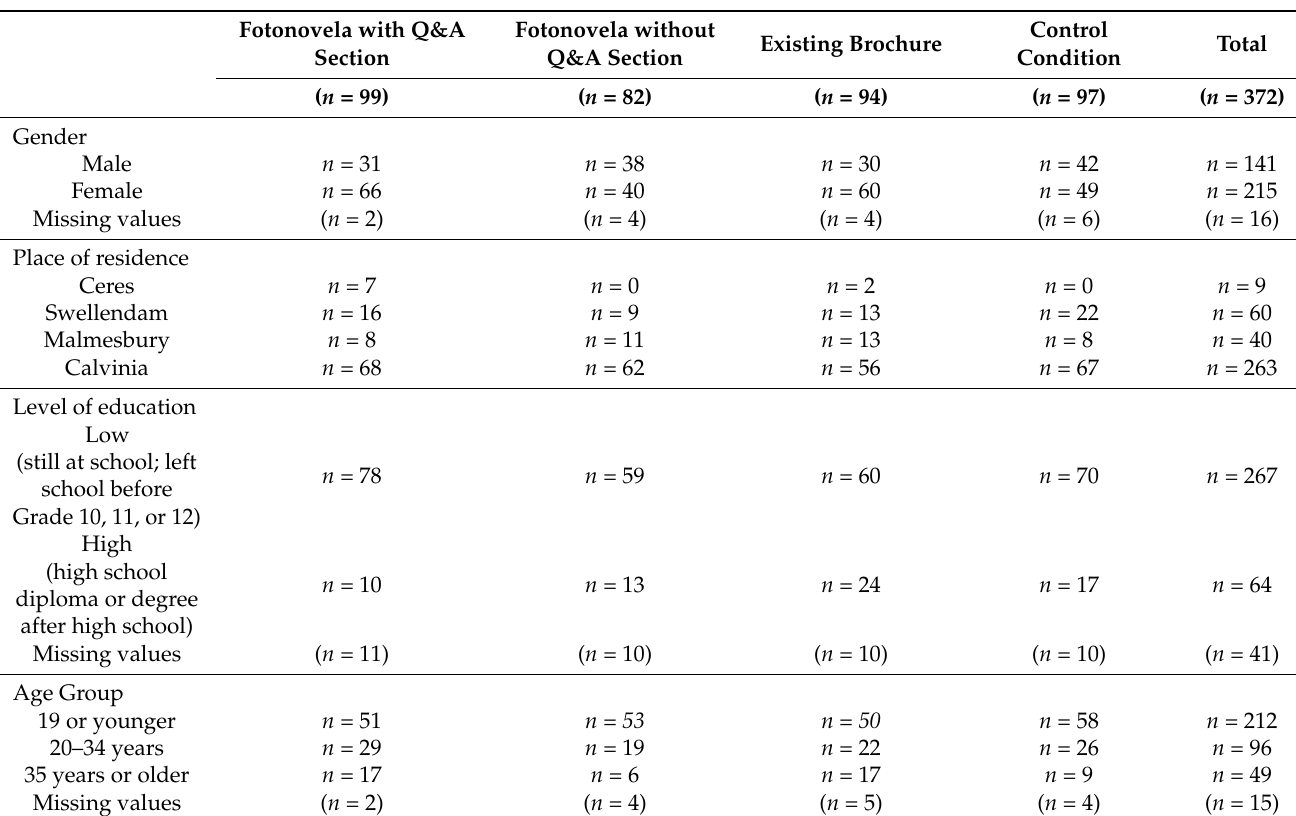
Table 1. Descriptive statistics for the part of the study related to